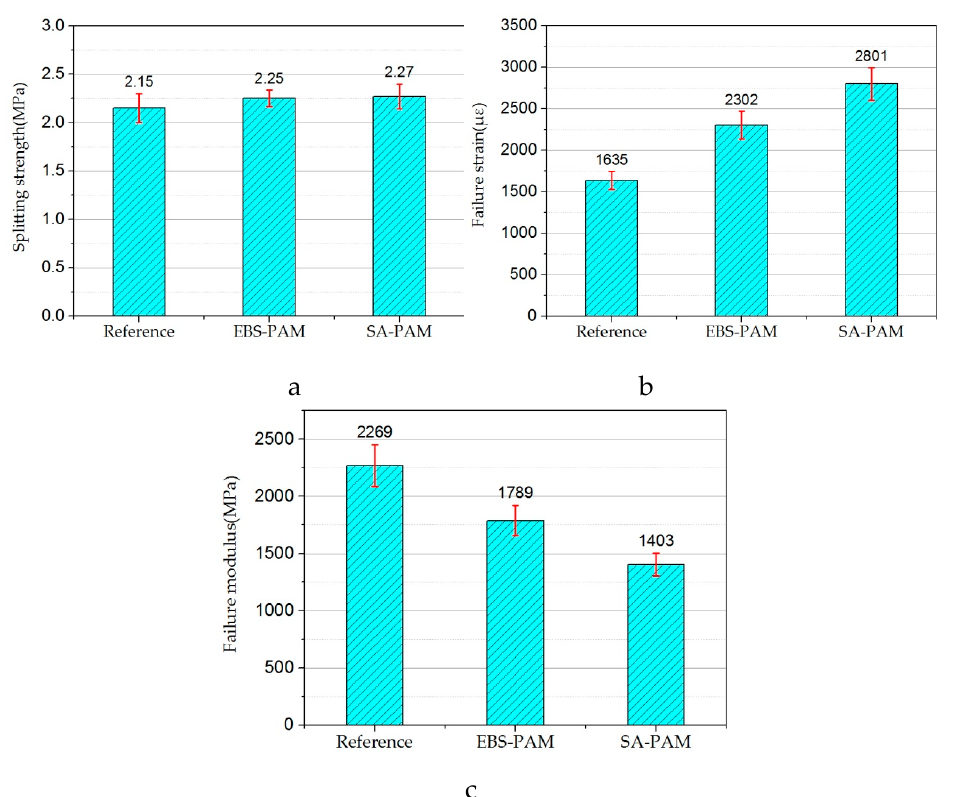
Figure 8. ( a ) The splitting strength; ( b ) the failure strain; ( c ) the failure stiffness modulus.